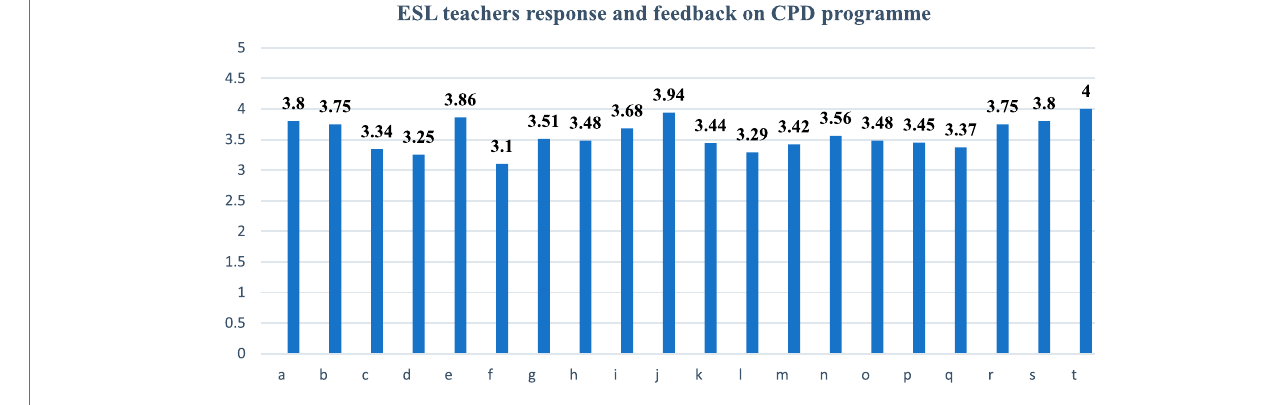
FIGURE 3 | EFL teachers ’ response and feedback on the CPD